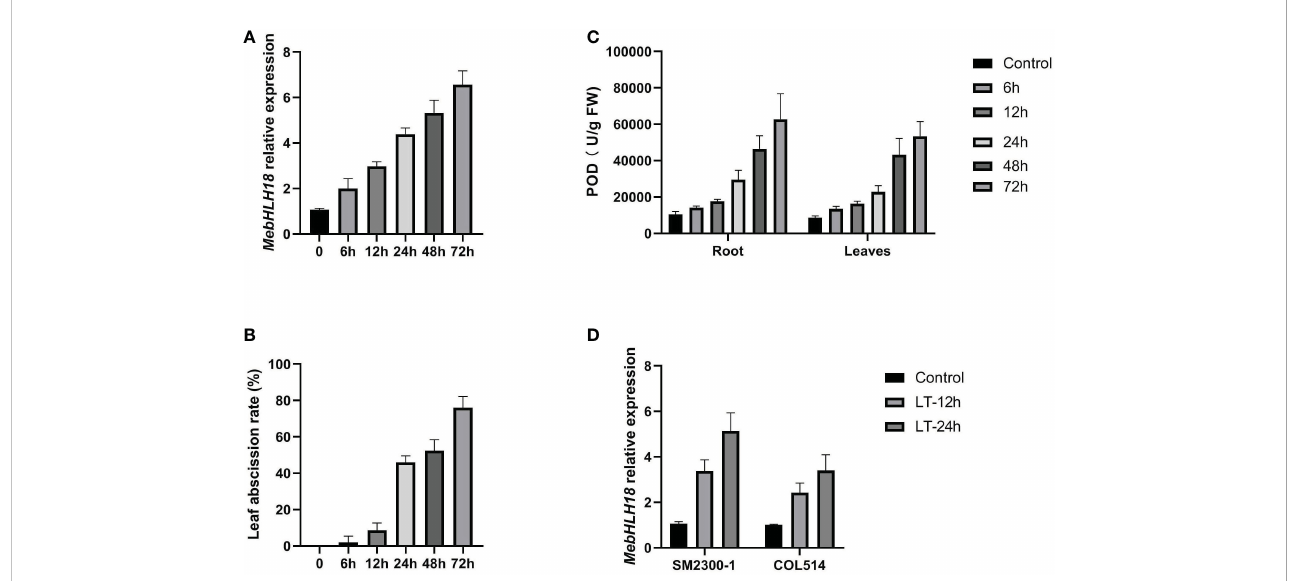
FIGURE 2 The expressions of MebHLH18 , POD levels as well as leaf abscission displayed similar pattern under cold treatment. (A) The MebHLH18 expression levels in low temperature-treated (4°C) (0h, 6h, 12h, 24h, 48h and 72h) plants were analyzed by fl uorescence real-time quantitative polymerase chain reaction. (B) Leaf abscission rates were analyzed at 10 days recovery growth after low temperature-treated for six time points selected in (A) . (C) POD level analysis in low temperature-treated (4°C) (0h, 6h, 12h, 24h, 48h and 72h) plants were analyzed. (D) The MebHLH18 expression levels in SM2300-1 and COL514 cassava genotypes under low temperature treated for 12h and 24h. Cassava grown for 120 days was selected as the experimental material. The cassava plants with consistent growth were selected for low-temperature treatment. After the plants were treated at 4°C for 24 hours, the control plants were placed in the greenhouse for normal growth. The treated and control plants were placed in the greenhouse simultaneously for growth recovery. Samples were taken after 10 days of growth recovery. Five plants selected as one samples, each sample was replicated four times. The value is represented as mean ± standard deviation (n=20) in (A – D)